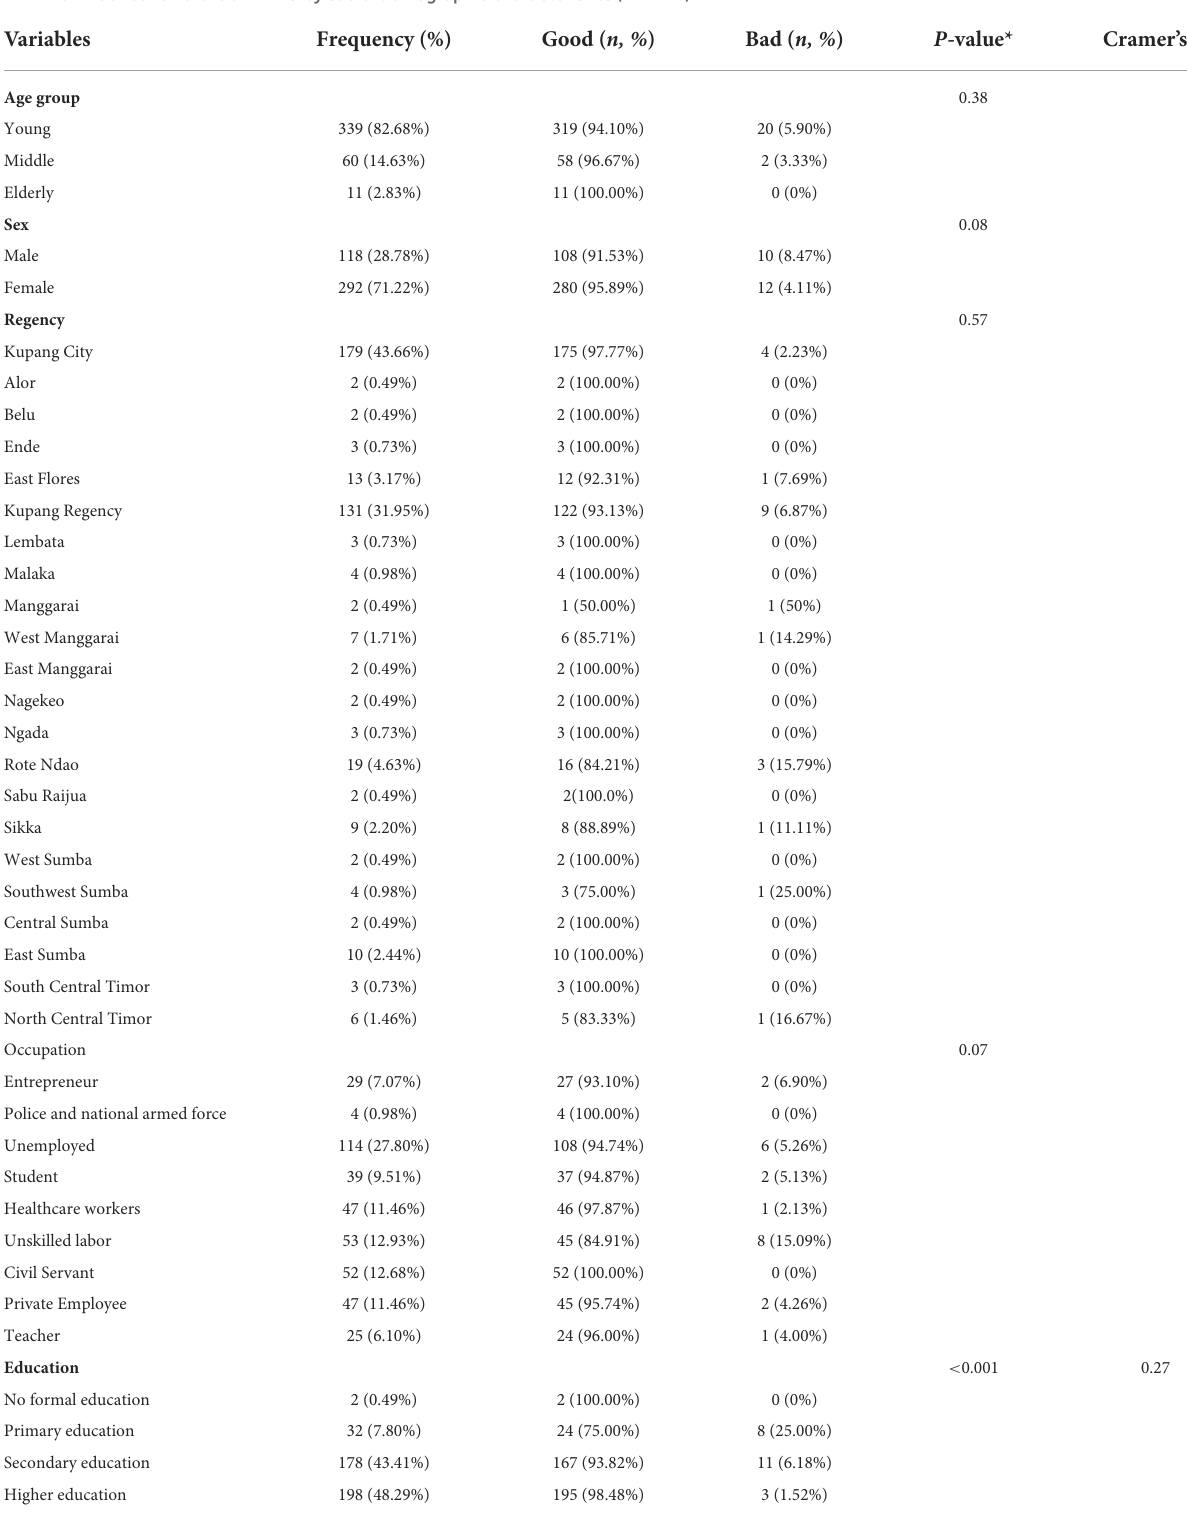
TABLE 5 Practice toward COVID-19 by socio-demographic characteristics ( n =